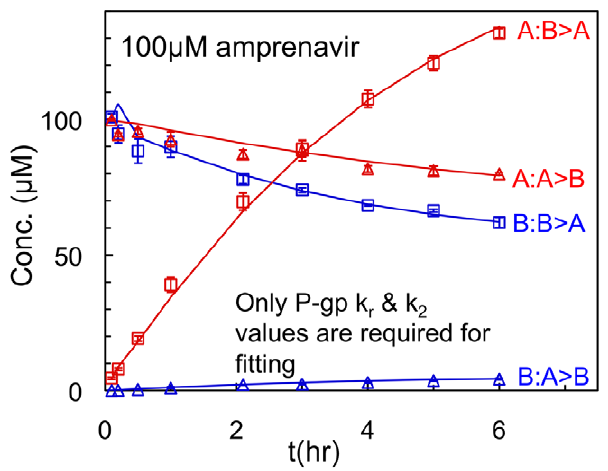
Figure 2. Amprenavir transport over 6 hours across the MDCKII-hMDR1 cell monolayer. Amprenavir transport A . B and B . A over 6 hours across the MDCKII-hMDR1 confluent cell monolayer with 100 mM on the donor side initially. The symbols show the data points with error bars showing the standard deviation of triplicate measurements. A:B . A denotes the substrate concentration in the apical chamber when the basolateral chamber is the donor, while B:B . A denotes the substrate concentration remaining in the donor basolateral chamber. The A:B . A transport is high because P-gp actively pumps drug into the receiver apical chamber. The B:A . B denotes the substrate concentration in the basolateral chamber when the apical chamber is the donor, while A:A . B denotes the substrate concentra- tion remaining in the donor apical chamber. The B:A . B transport is low because P-gp actively pumps drug back into the donor apical chamber. The lines show the best fits for amprenavir transport assuming there are no other transporters except